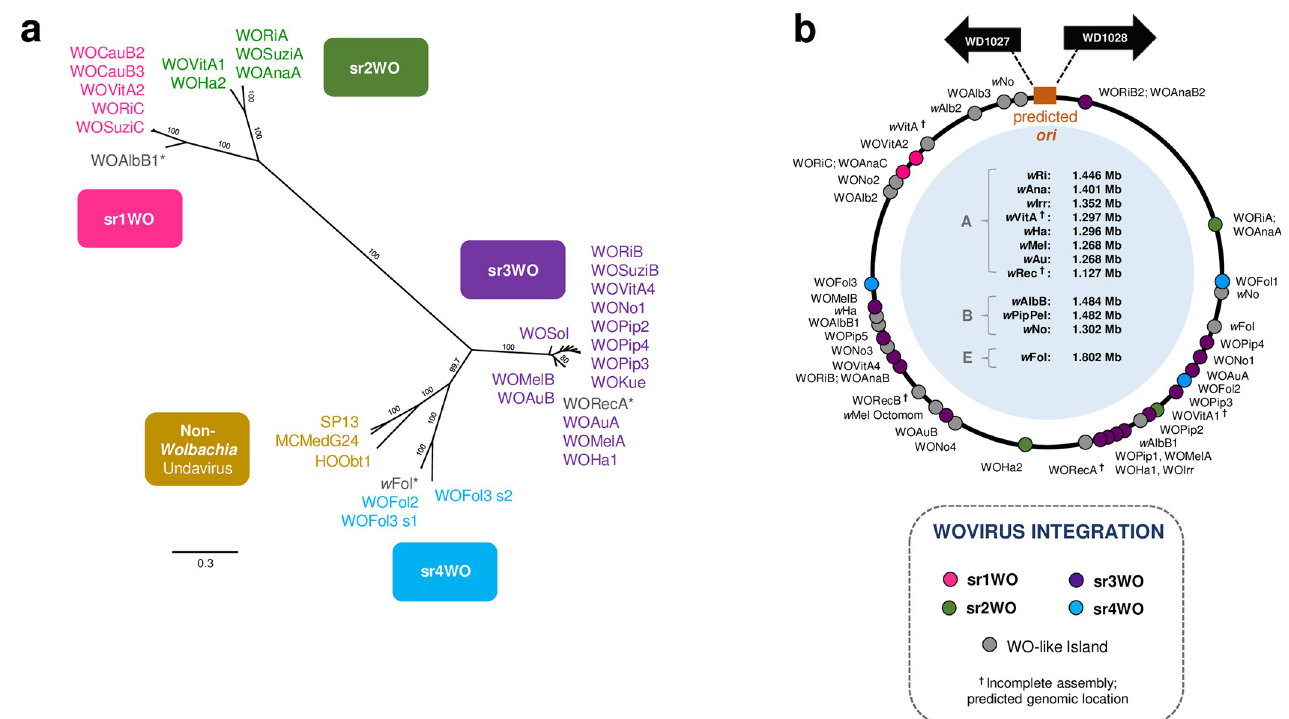
Fig 3. Phylogeny of Wovirus large serine recombinase correlates with module synteny and genomic integration. (a) A phylogenetic tree of the proposed Wovirus recombinase sequence illustrates the utility of this gene as a WO-typing tool to distinguish prophage WO variants. Four distinct clades correlate with sr1WO-sr4WO genome organization shown in Fig 2. Non- Wolbachia sequences represent similar prophages (undaviruses, discussed below) from other bacterial hosts, such as the prophage HOObt1 of Holospora obtusa , an endonuclear symbiont of Paramecium . The tree was generated by Bayesian analysis of 283 amino acids using the JTT-IG model of evolution. Consensus support values are indicated for each branch. ( � ) indicates that the prophage regions are highly degraded; while they likely originated from the corresponding prophage group, they are now classified as WO-like Islands (S7 Fig). (b) Wovirus integration loci are concentrated opposite the putative origin of replication, ori . All Wolbachia genomes have been standardized where each dot represents % nucleotide distance calculated by: (nucleotide distance between 5’-WO and ori / genome size) � 100. ( † ) indicates the genome is not closed/circularized; genomic locations are estimated based on alignment of contigs to a reference genome (obtained from authors in [51,52]) and may not reflect true orientation.